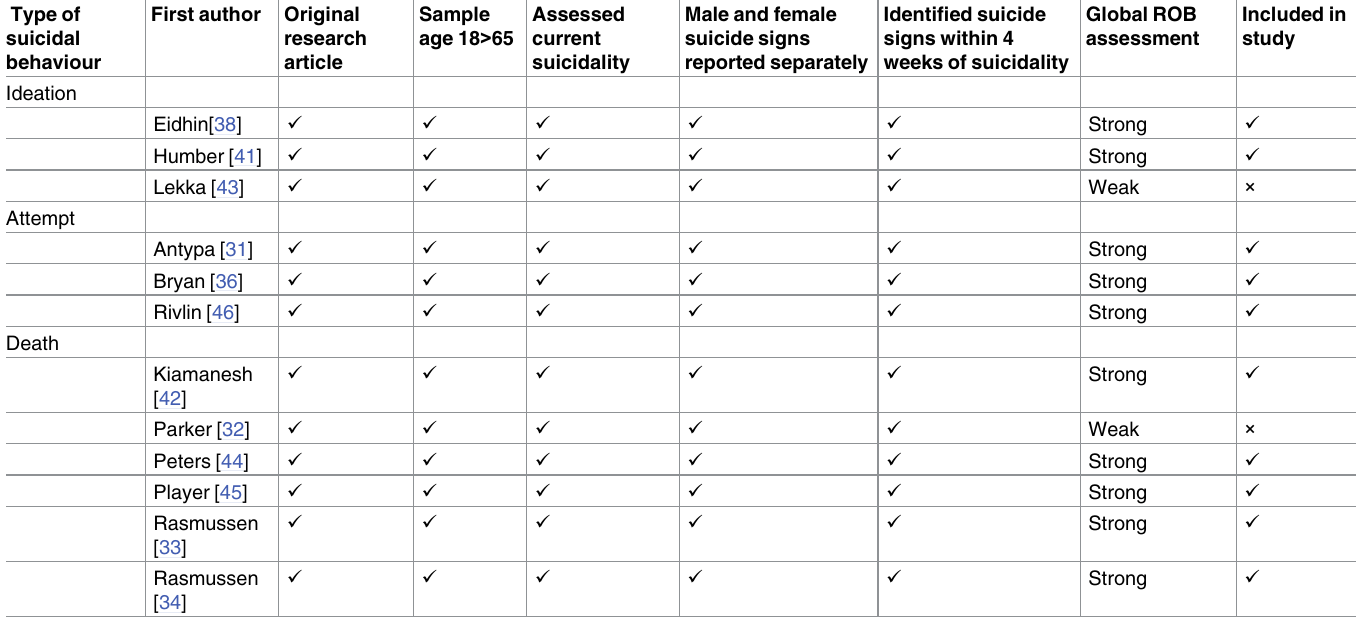
Table 5. Article compliance and global ROB assessment rating for inclusion in final